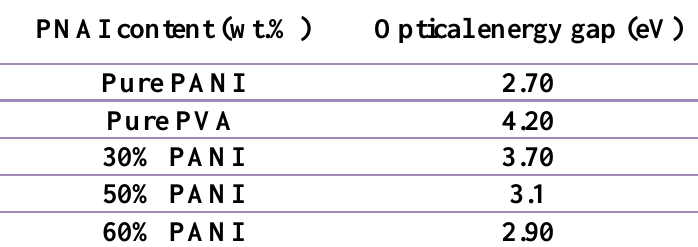
Table 1: The optical energy gap of polyaniline and blending.